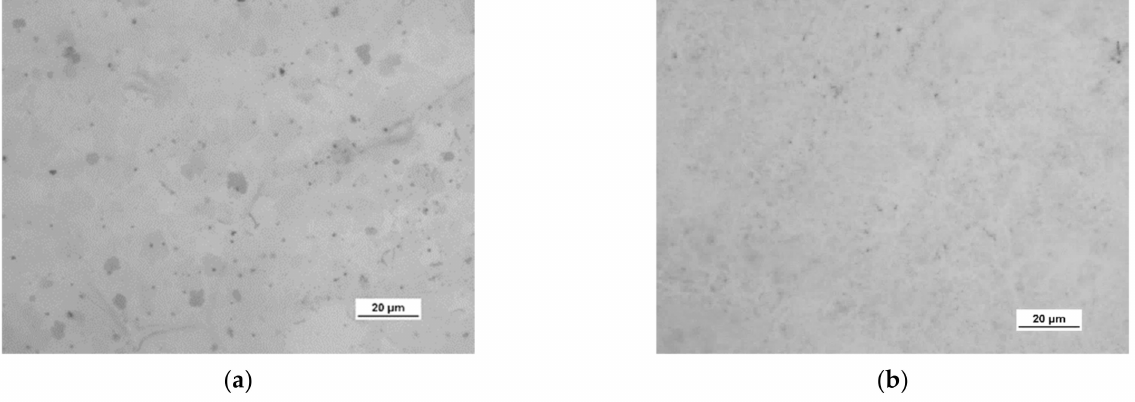
Figure 10. Optical images of the surface microstructure of: ( a ) HSMG ® and ( b ) CVD graphene transferred to O 2 RF PACVD plasma-etched Al 2 O 3 ceramics.